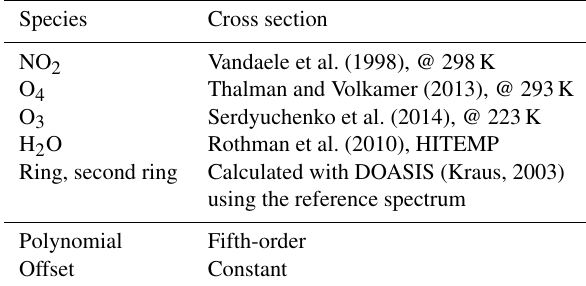
Table 1. Settings of the spectral